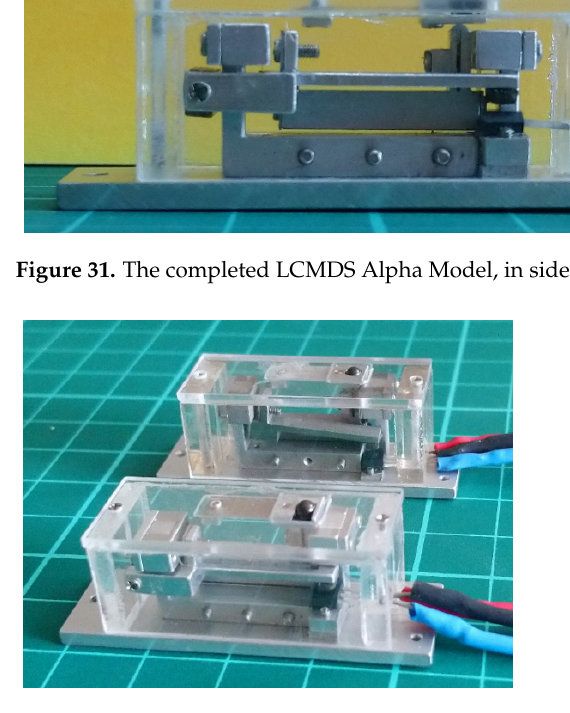
Figure 32. Two packaged LCMDS prototypes, the Alpha Model in the foreground.